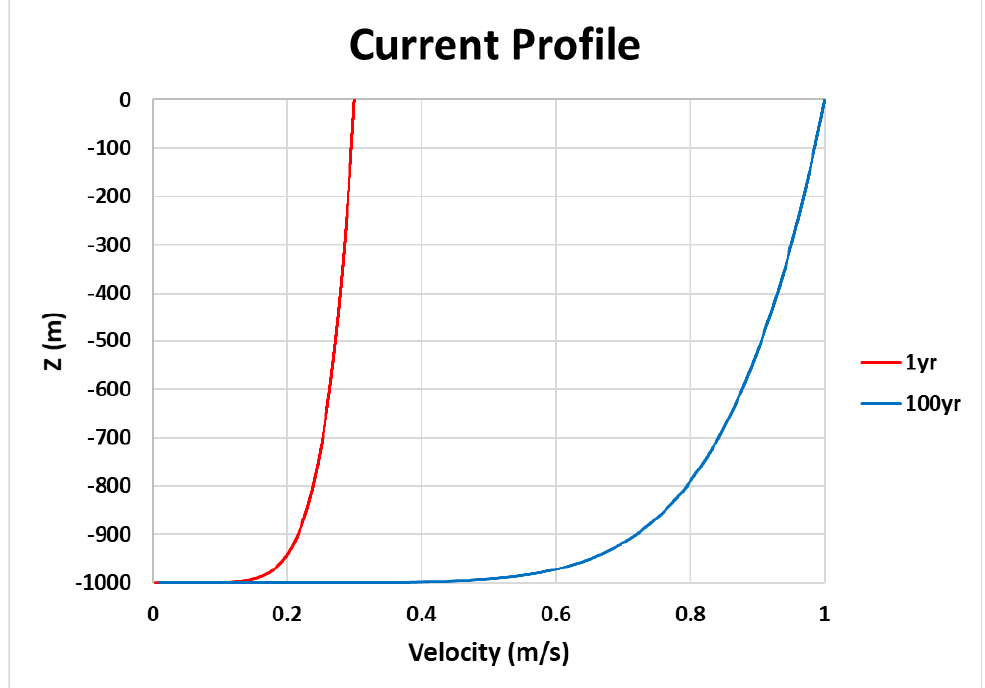
Figure 8. Current Profile, 1-yr and 100-yr Cases. Table 5. FPSO Dimension and Specification [32].